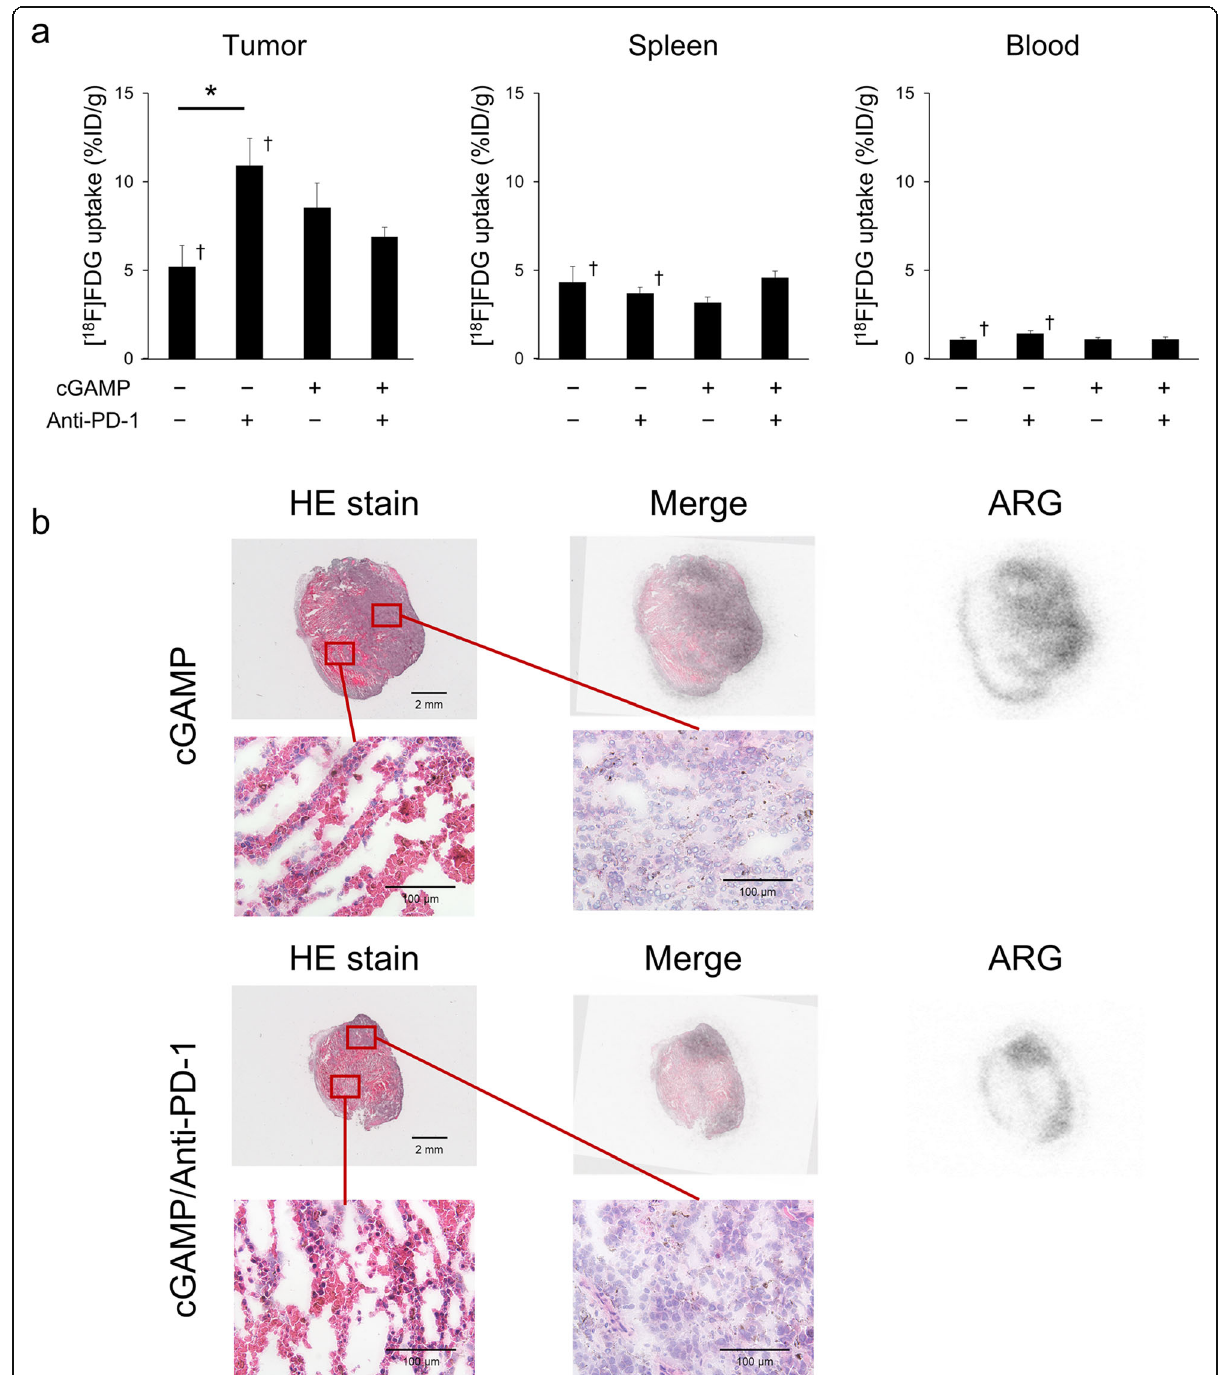
Fig. 2 Ex vivo validation of [ 18 F]FDG uptake. a Ex vivo biodistribution of tumors, spleens, and blood on day 7 ( n = 6 – 7). Data of the non- treatment group and anti-PD-1-treated group were quoted from [11]. b HE-stained tissue sections and autoradiograms of the cGAMP-treated group and the cGAMP/anti-PD-1 combination group tumors. Data represent the mean ± SEM; * p < 0.05; † Adapted from